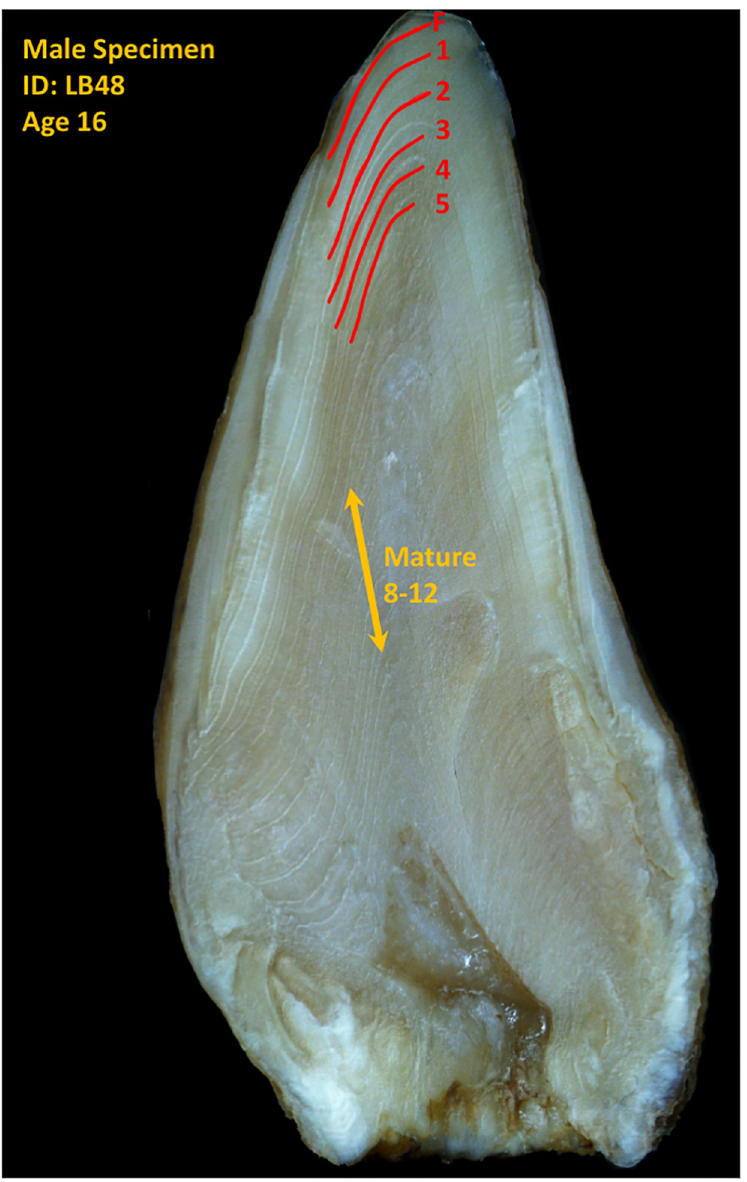
Fig 2. A sectioned H . ampullatus tooth prior to sampling. GLGs are annotated: F = fetal, 1–5 = years (red lines) and mature = sampling across years 8–12 (yellow